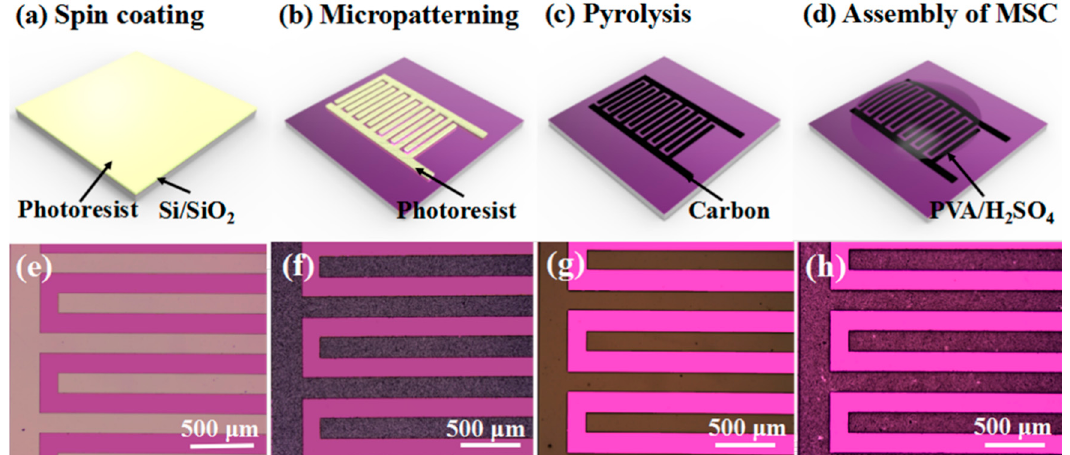
Figure 1. ( a – d ) Microfabrication process of carbon/CNT microelectrode-based all-solid-state microsupercapacitor (MSC) (carbon/CNT-MSC). ( e ) Optical image of micropatterned photoresist. ( f ) Optical image of micropatterned photoresist/CNTs. ( g ) Optical image of carbon microelectrodes. ( h ) Optical image of carbon/CNTs